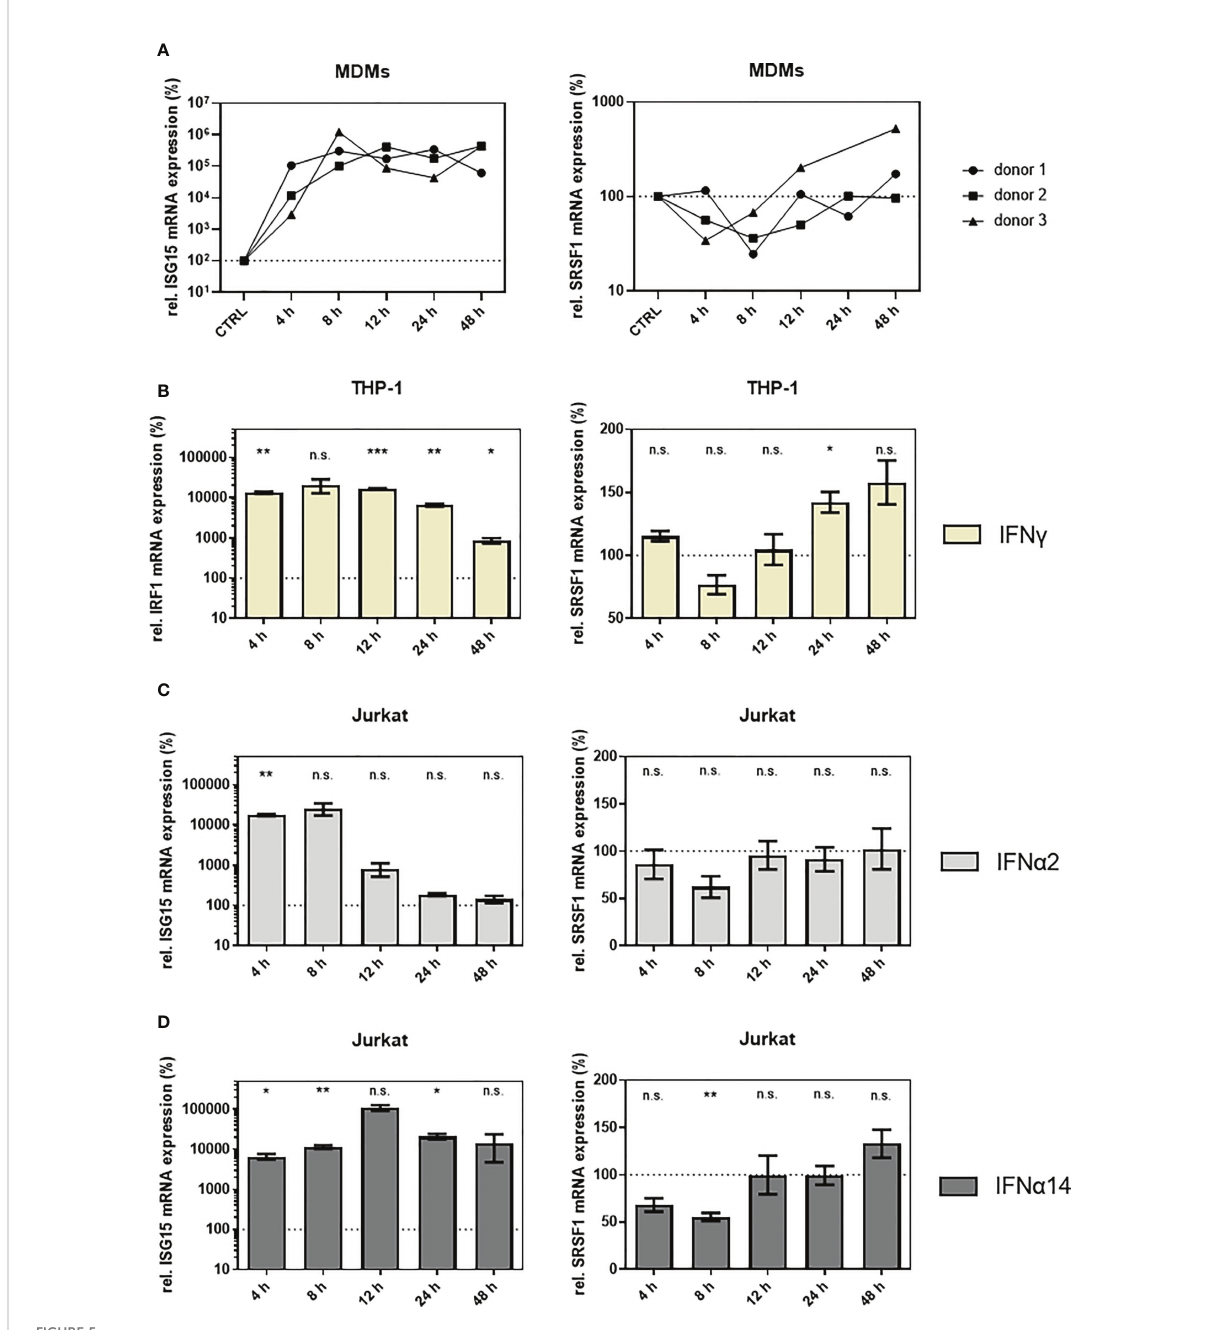
FIGURE 5 SRSF1 mRNA levels are differentially regulated upon treatment of HIV-1 target cells with IFNs. (A) Monocyte-derived macrophages (MDMs) were treated for 48 h with 10 ng/ml of IFN a 14. After harvesting the cells, RNA was extracted and subjected to RT-qPCR. Relative mRNA expression levels of ISG15 and SRSF1 are shown. Expression levels were normalized to GAPDH. Time point of 24 h only includes two biological replicates. (B) Differentiated THP-1 cells were stimulated with IFN g (10 ng/ml) for 48 h before cells were harvested and RNA was isolated. Relative mRNA expression levels of IRF1 and SRSF1 were measured via RT-qPCR. GAPDH was used as a house-keeping gene for normalization. Mixed-effects analysis followed by Dunnett ’ s post-hoc test was conducted to determine whether the difference between the group of samples reached the level of statistical signi fi cance (* p < 0.05, ** p < 0.01, *** p < 0.001, and ns, not signi fi cant). Mean ( ± SEM) of n = 4 biological replicates is shown. (C, D) Relative mRNA expression levels of ISG15 and SRSF1 upon stimulation with (C) IFN a 2 or (D) IFN a 14 in Jurkat cells. ACTB was used as a house-keeping gene for normalization. Mixed-effects analysis with Dunnett ’ s post-hoc test was performed to determine whether the difference between the group of samples reached the level of statistical signi fi cance (* p < 0.05, ** p < 0.01, *** p < 0.001, and ns, not signi fi cant). Mean ( ± SEM) of n = 4 biological replicates is